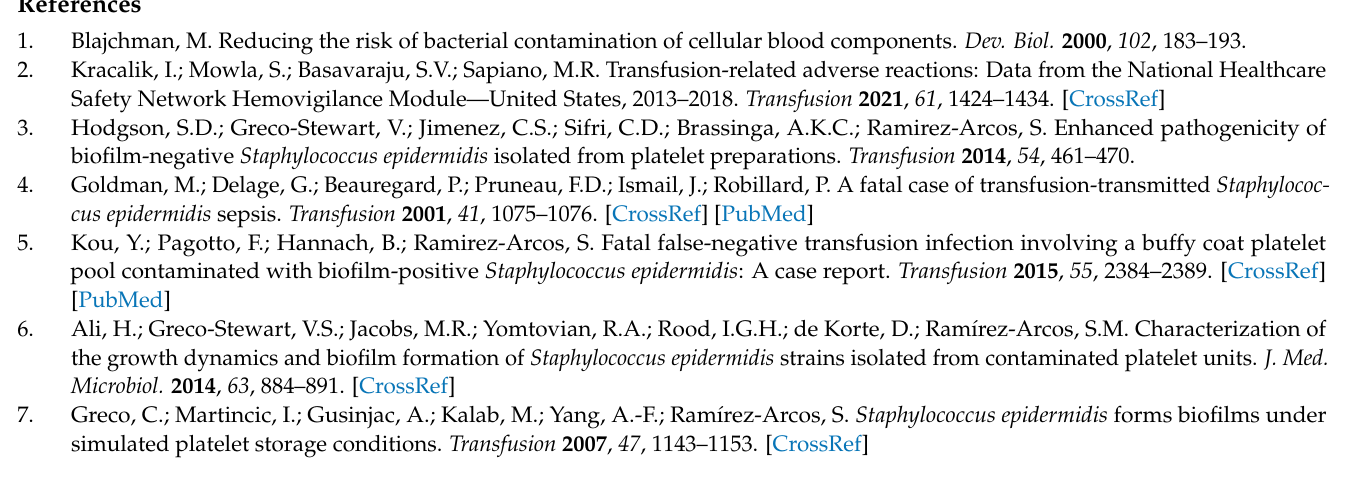
Table S1. Diameter of silica NP by DLS. Table S2. Dried thickness of the MAAC applied on textured PVC-DEHP by SEM. Table S3. Atomic distribution at the surface of MAAC treated and untreated PVC-DEHP by